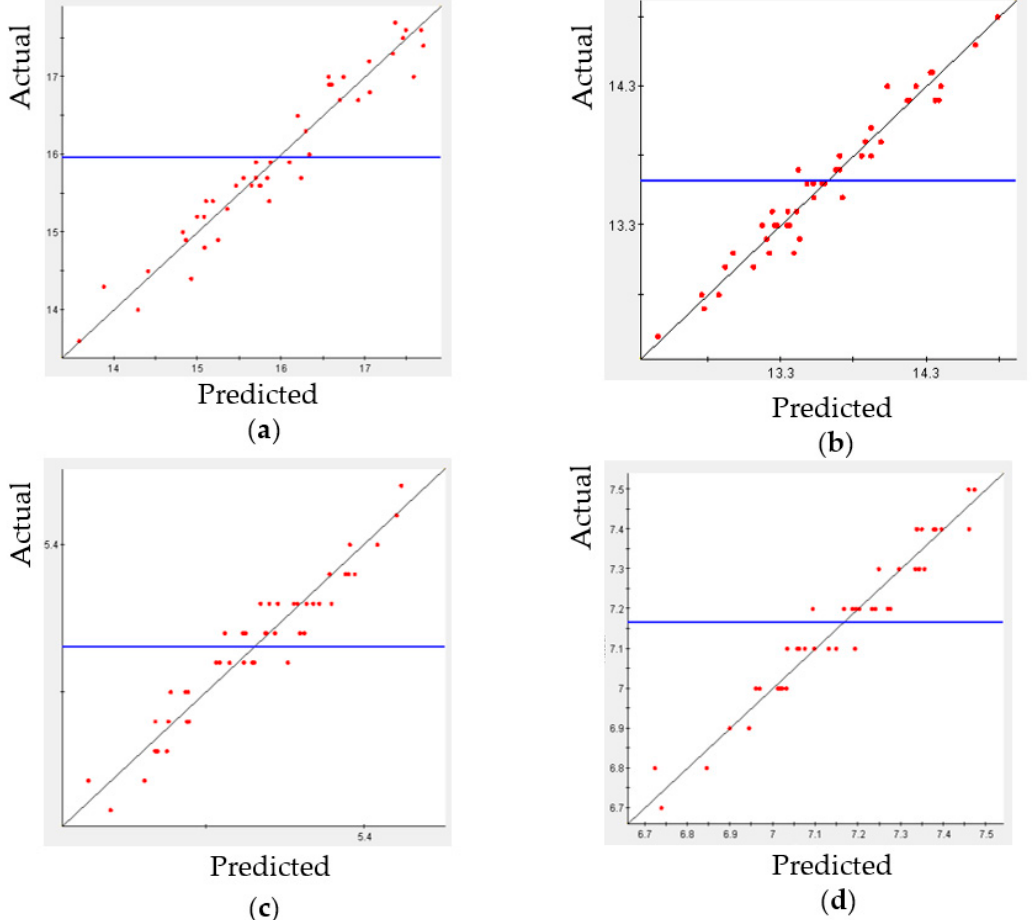
Figure 6. Fit graphs of response values of ( a ) maximum thickening rate in the slow cooling zone; ( b ) maximum thinning rate in the slow cooling zone; ( c ) maximum thickening rate in the rapid cooling zone; and ( d ) maximum thinning rate in the rapid cooling zone.